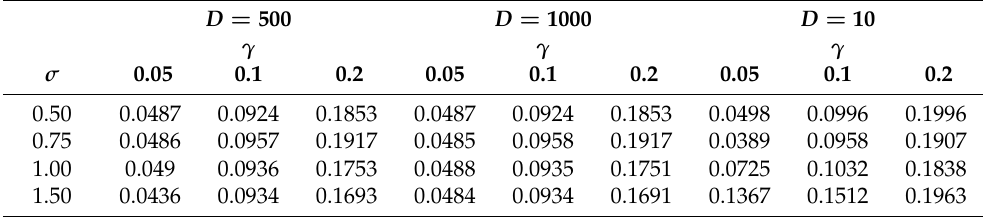
Table 7. The RMSE for the indicated value using the SVR method; see abbreviations in Nomenclature.